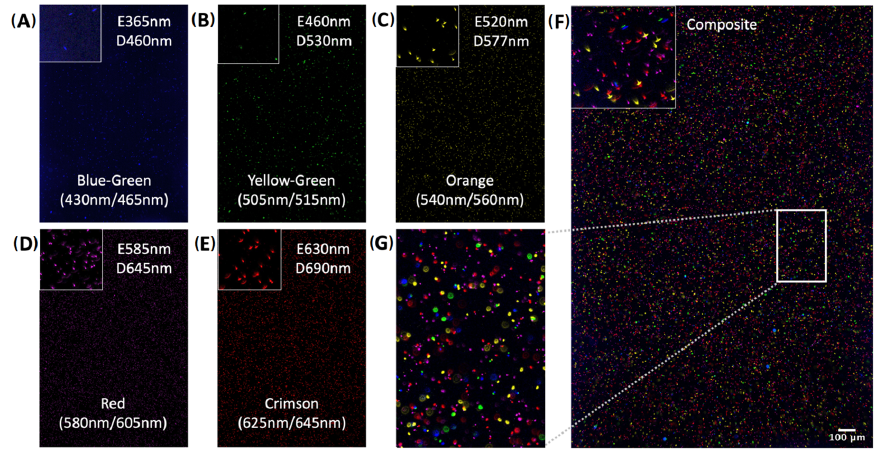
Figure 2. Validation of each spectral channel and the specificity of the Tissue Imager. Validation of each spectral channel and the specificity of the Tissue Imager. Using 1 µ m fluorescent beads at a 1:2000 dilution, each spectral channel was calibrated. ( A ) Blue-green fluorescence beads with excitation/emission peaks at 430 nm and 465 nm illuminated at 365 nm and detected at 460 nm. ( B ) Yellow-green fluorescence beads with excitation/emission peaks at 505 nm and 515 nm, illumi- nated at 460 nm and detected at 530 nm. ( C ) Orange fluorescence beads with excitation/emission peaks at 540 nm and 560 nm, illuminated at 520 nm and detected at 577 nm. ( D ) Red fluorescence beads with excitation/emission peaks at 580 nm and 605 nm, illuminated at 585 nm and detected at 645 nm. ( E ) Crimson fluorescence beads with excitation/emission peaks at 625 nm and 645 nm, illuminated at 630 nm and detected at 690 nm. ( F ) Composite image of all channels. ( G ) Inset of composite image F. Scale bar, 100 µ m.